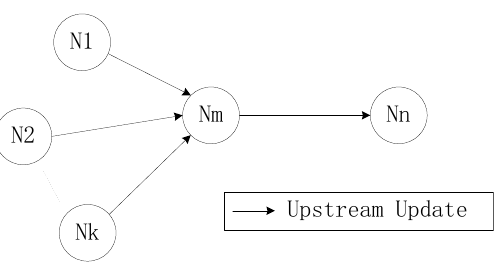
Figure 5. Parameter delivery procedure in